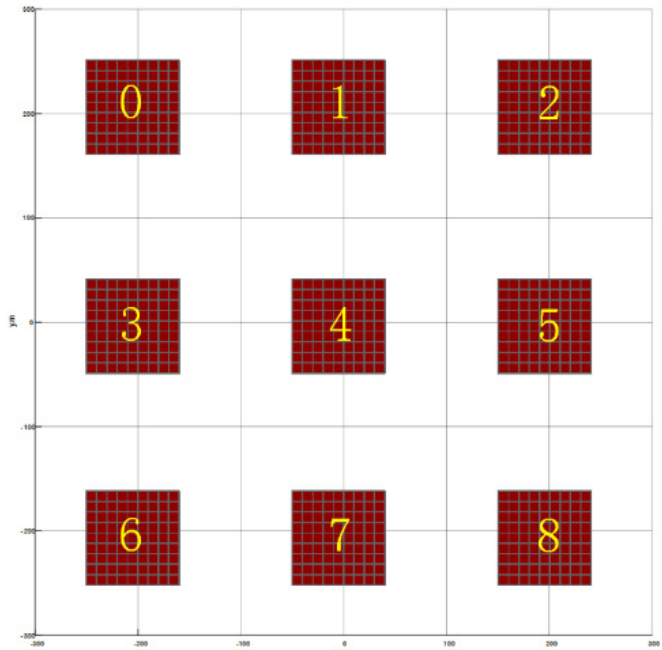
Figure 6. The test area is divided into 9 grid areas on a 3 × 3 equally spaced grid and numbered in order, from left to right and top to bottom. The labeled numbers 0–8 are defined as the different horizontal and vertical positions’ point numbers.